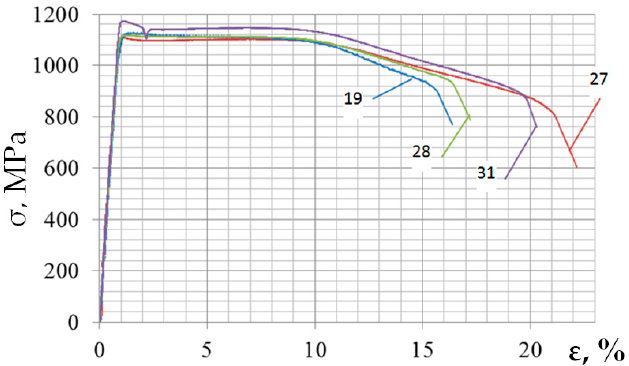
Figure 3. Stress-strain diagrams of the tested specimens from alloy VT23 (loading modes are given in Table 2).